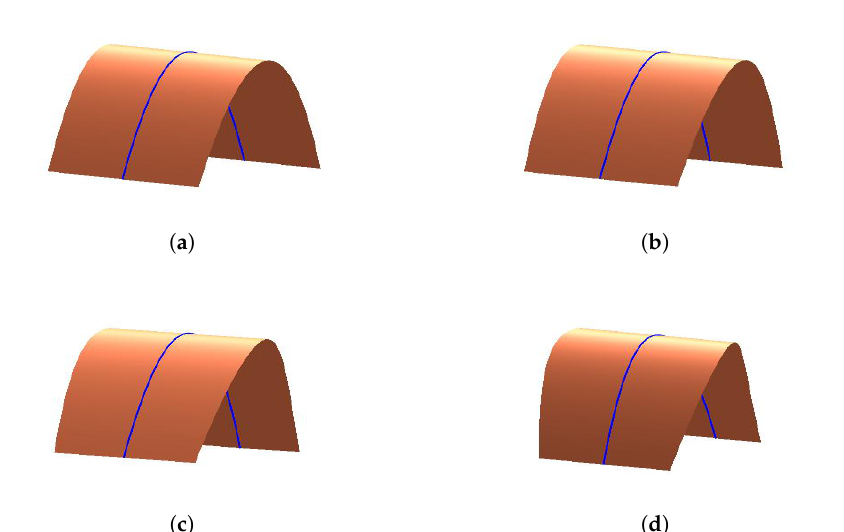
Figure 10. The effects of parameter α 1 on the developable surface through geodesic. ( a ) α 1 = π π